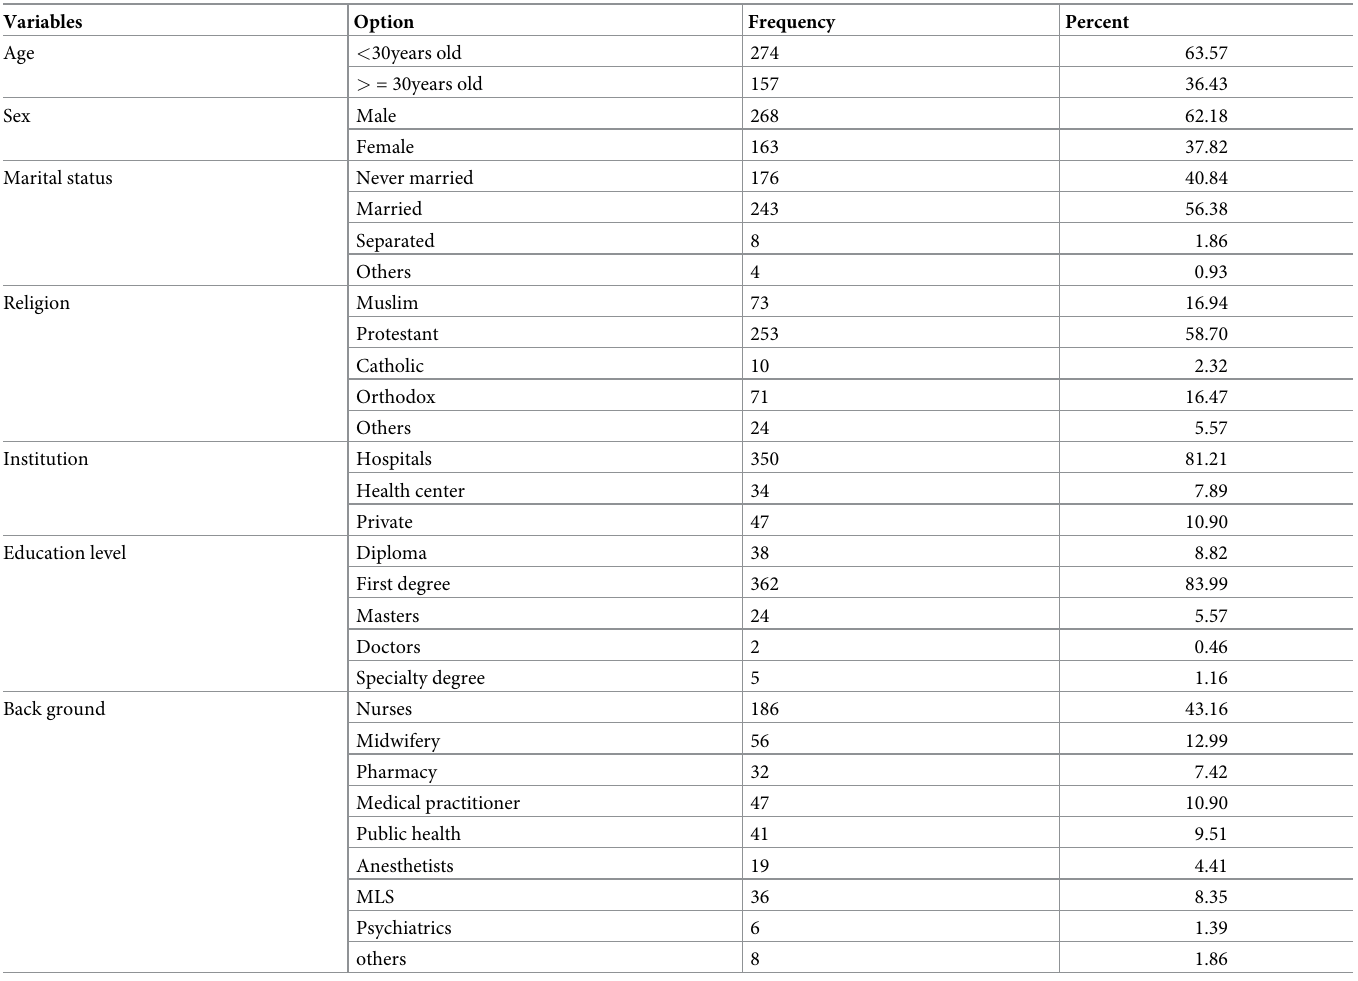
Table 1. Socio demographic characteristics of the health professionals in Nekemte city, Western Ethiopia, 2021.